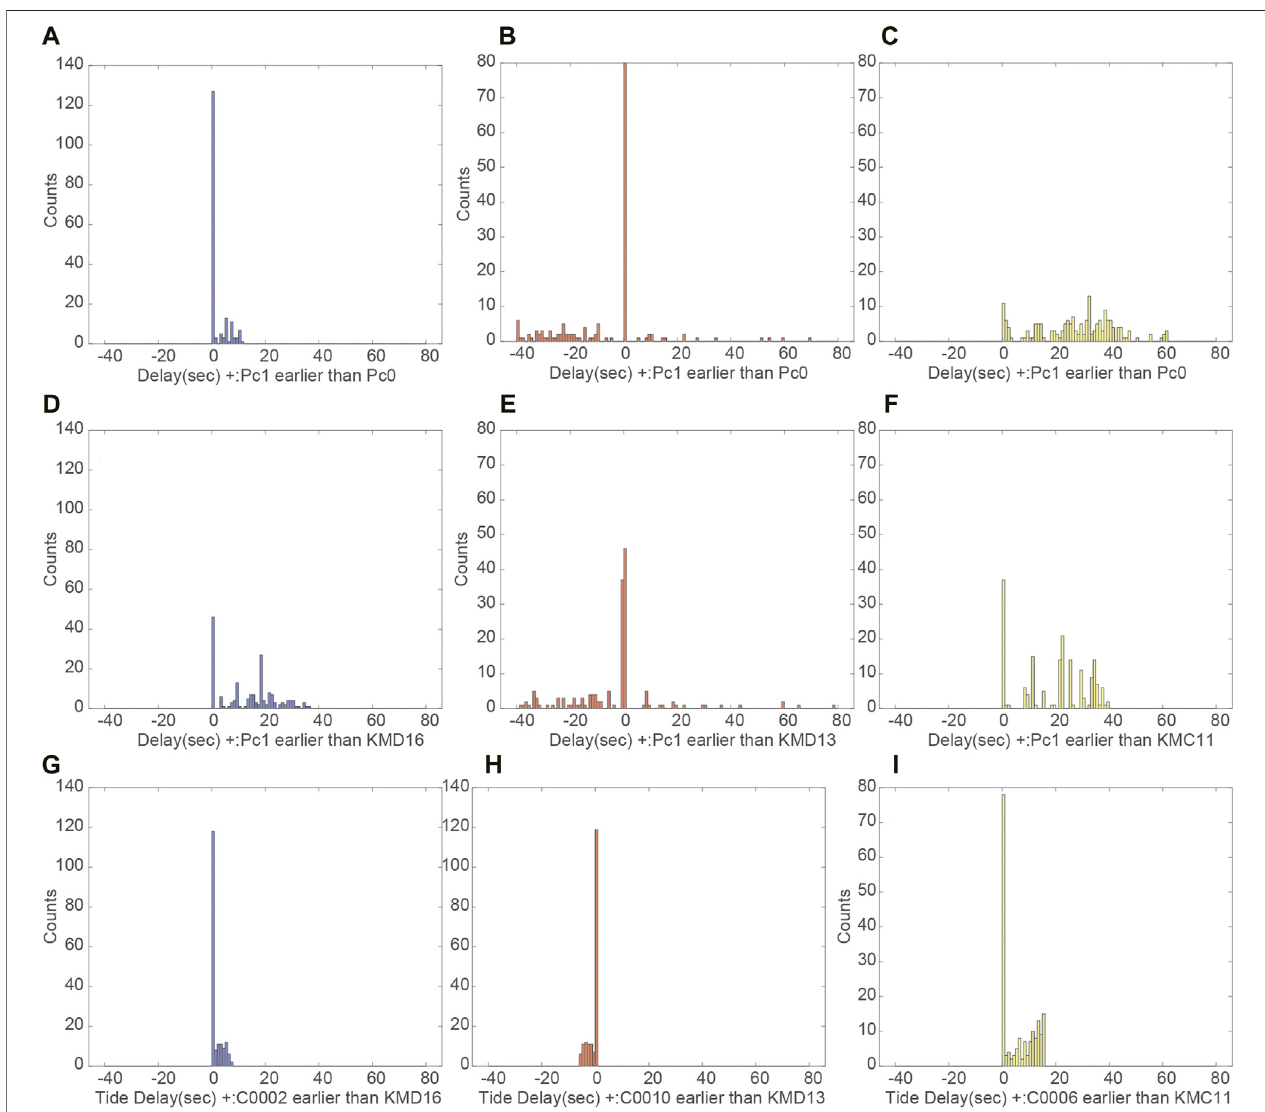
FIGURE 5 | Frequency distribution histograms of the time lag t 0 between raw data of Pc1 and the reference sea fl oor pressure: Pc0 at (A) C0002, (B) C0010, (C) C0006, (D – F) P DONET _raw; (D) KMD16, (E) KMD13, (F) KMC11, (G – I) expected from theoretical tidal component between boreholes and nearby DONET stations: (G) C0002-KMD16, (H) C0010-KMD13, and (I) C0006-KMC11, respectively.